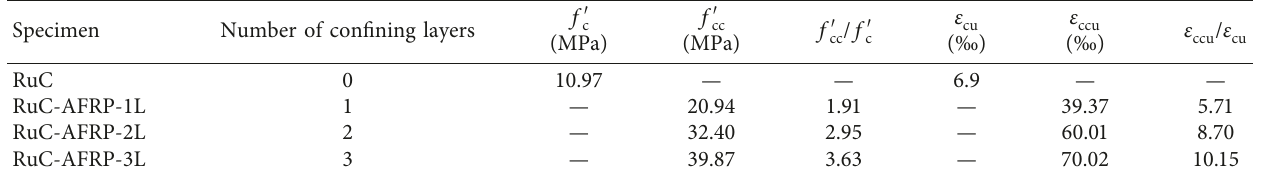
Figure 5: Average stress-strain curves of unconfined and AFRP-confined rubberized concrete short Table 4: Experimental values of confined rubberized concrete.